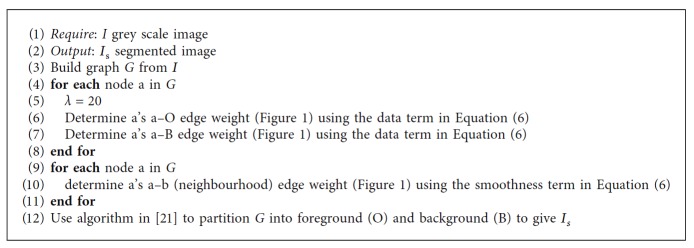
Cell segmentation using Equation (6).